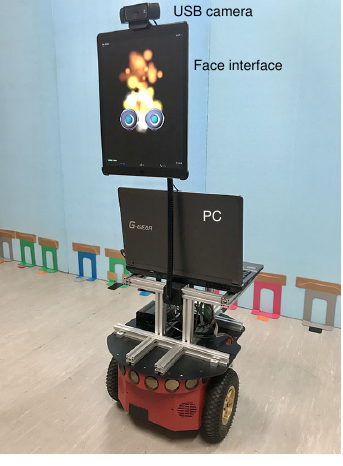
Figure 9. Mobile robot.